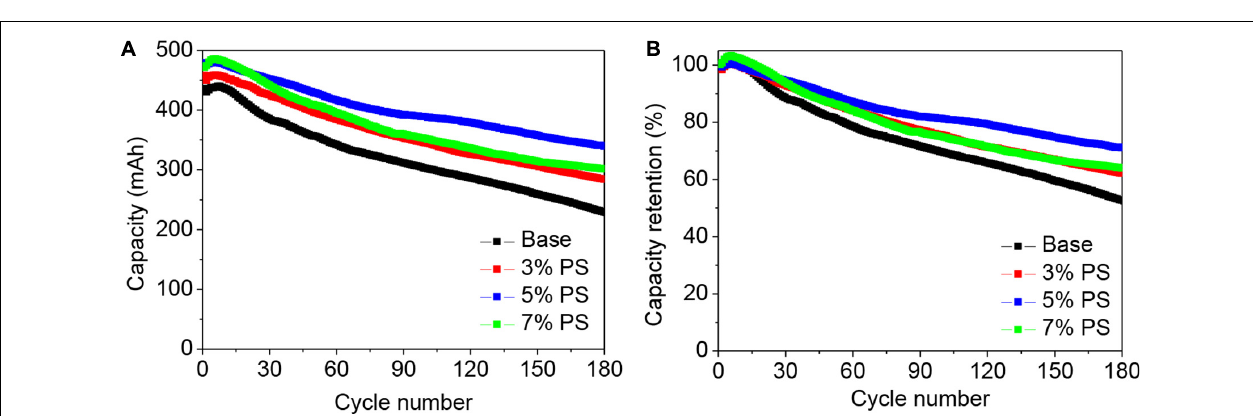
FIGURE 2 | Cycling stability (A) and corresponding capacity retention (B) of LiMn 2 O 4 /graphite cells using the electrolyte without (Base), with 3, 5, and with 7 wt.% PS. Charge-discharge rate was 1.0 C in the potential range of 2.75–4.20 V at 60 ◦ C.